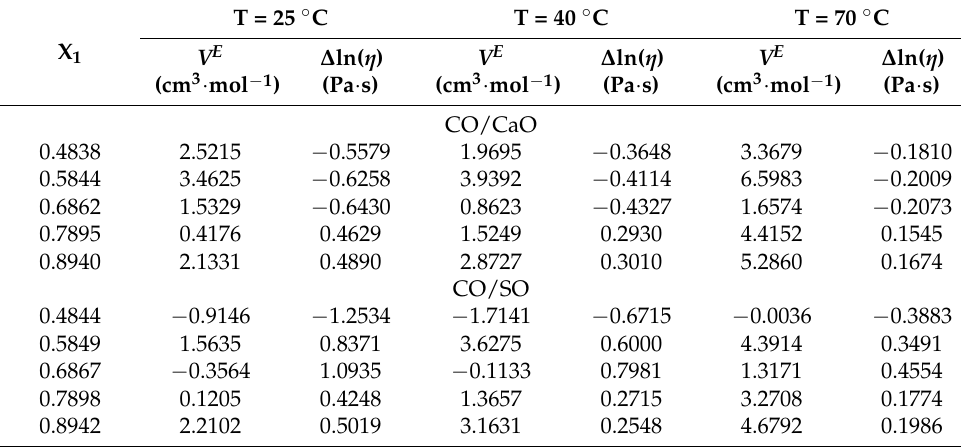
Table A1. Excess molar volume ( V E ) and viscosity deviation ( Δ ln( η )) of binary oil mixtures at 25, 40, and 70 °C.